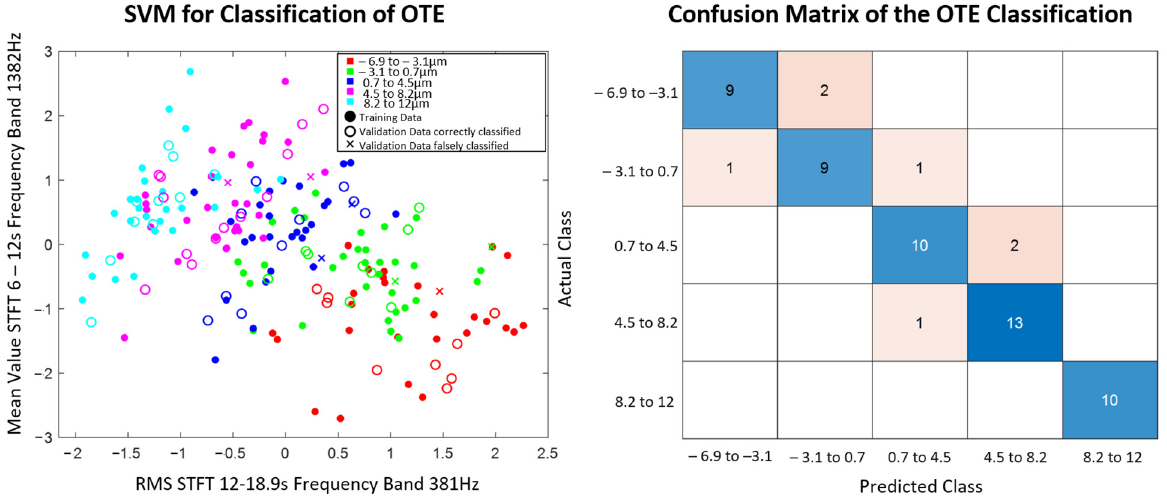
Figure 13. Best two features and confusion matrix of SVM to classify the OTE (feature selection: MANOVA, features from raw signal, and STFT).